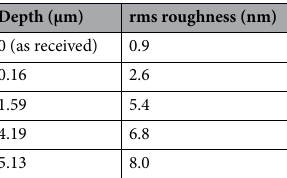
Table 1. Roughness measurements for the 15 × 15-mm, FJP-finished